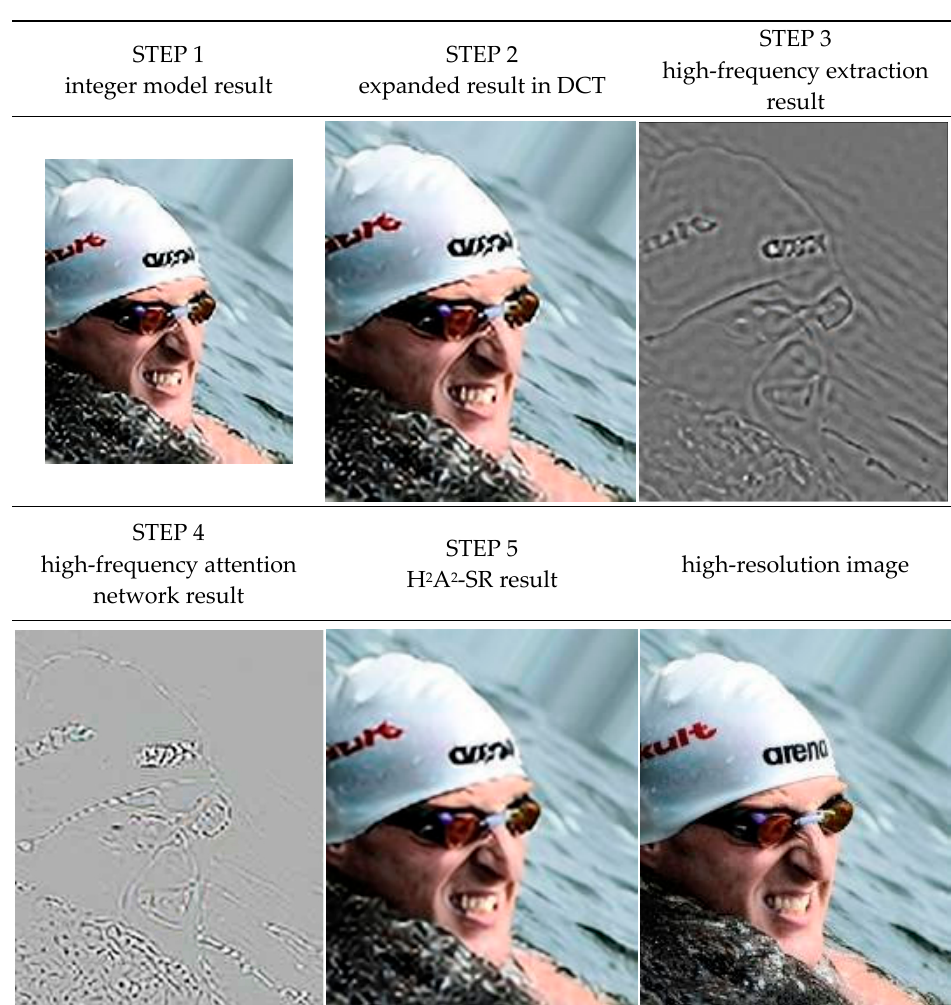
Figure 13. Result examples of H 2 A 2 -SR’s steps.